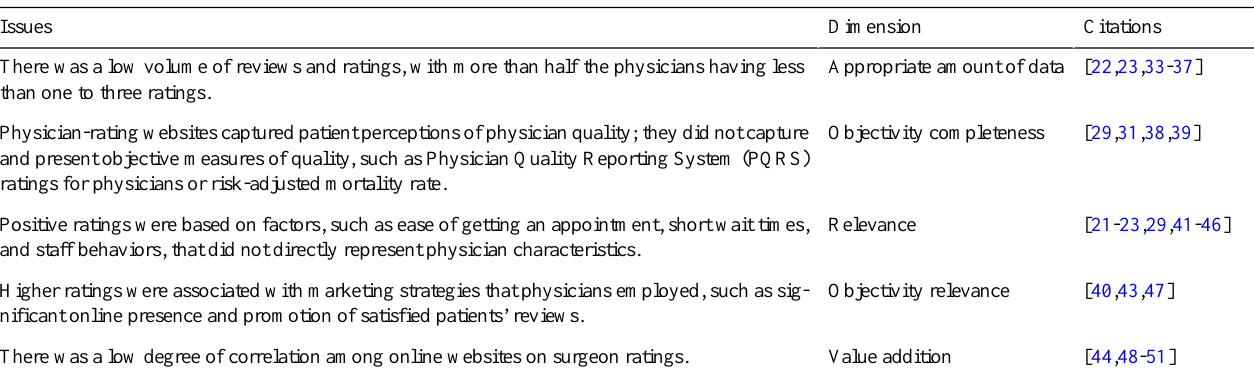
Table 4. Contextual data quality